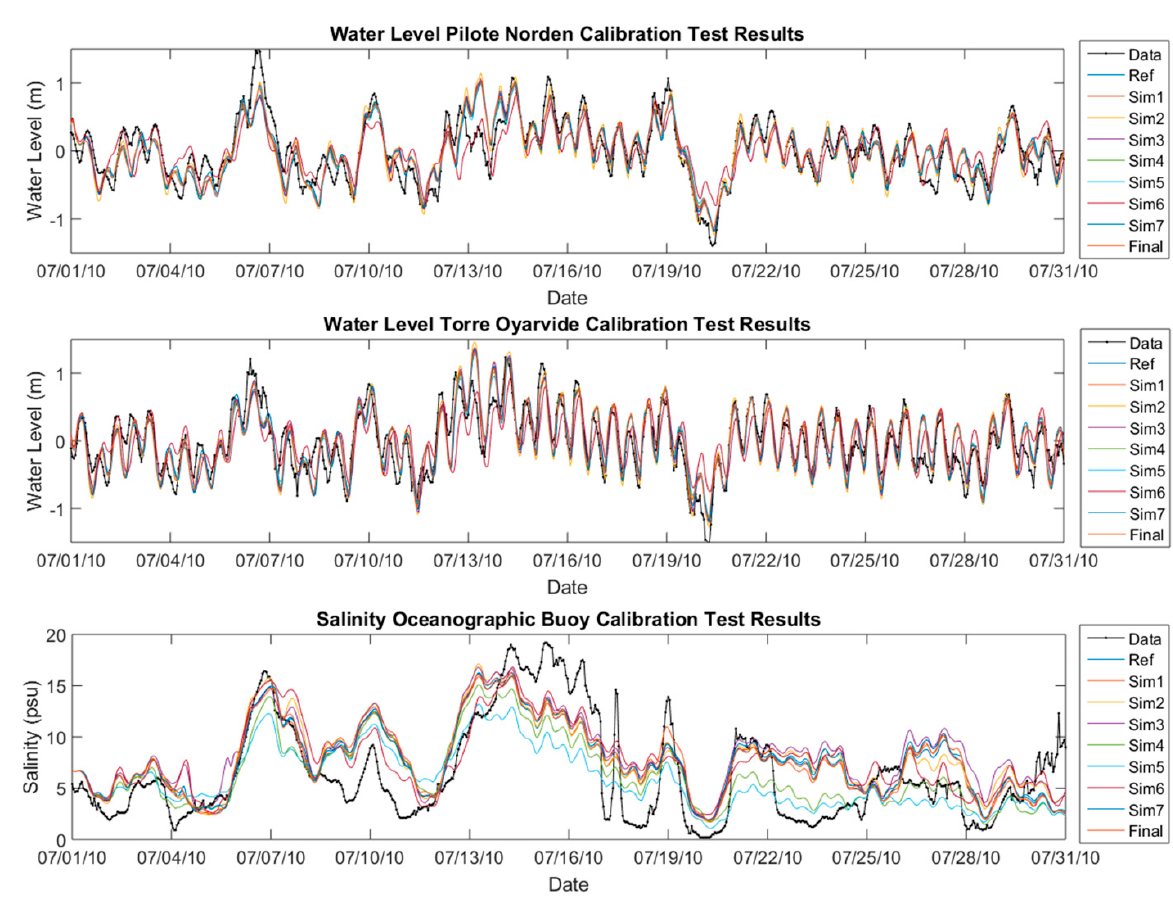
Figure A2. RPtide model calibration test results for the water level (m) at PN (upper panel), for the water level (m) ar TO (middle panel), and for salinity (ppt) at BO, with respect to data obtained in July 2010.